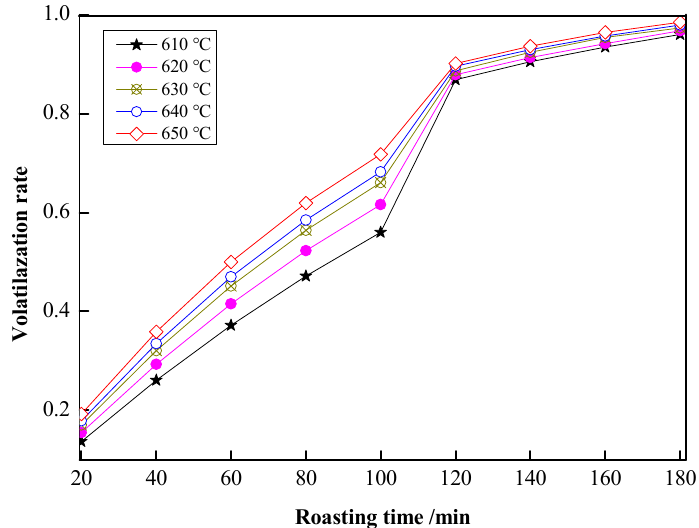
Figure 10. Volatilization rates of arsenic under different roasting temperatures and roasting times. Table 2. Kinetic equations of the SCM. Controlling Steps Kinetic Equations